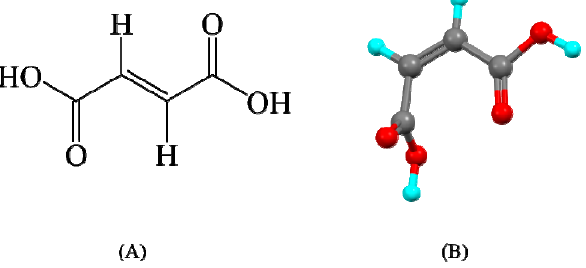
Figure 13. Chemical structure of fumaric acid ( A ) 2d and ( B ) 3d. Table 7. Physical and chemical properties of carboxylic acid ‐ based coformers.